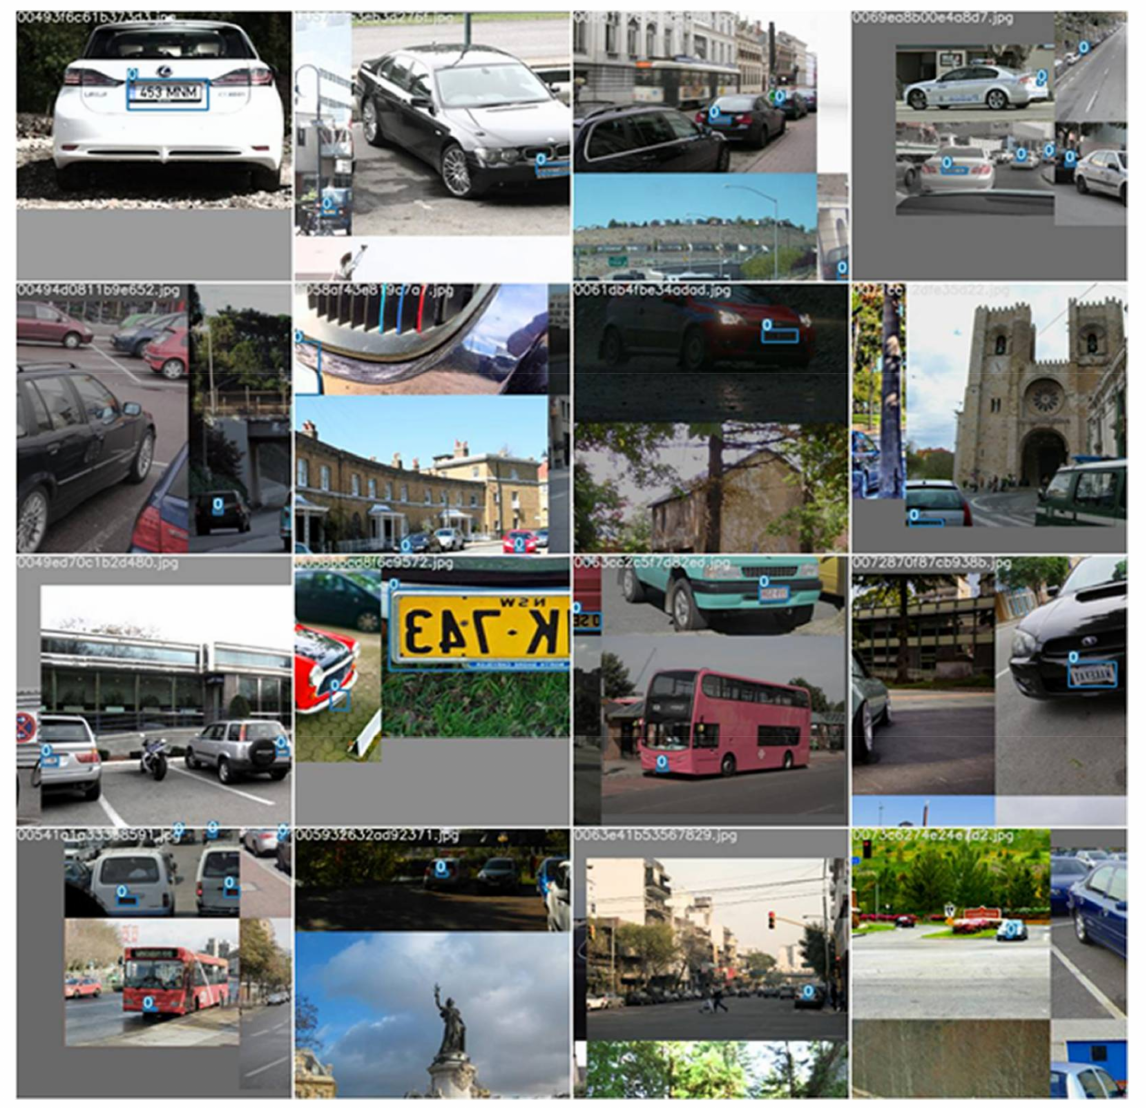
Figure 3. Random samples from the dataset (https://www.kaggle.com/datasets/dataturks/vehicle- number-plate-detection, accessed on 5 June 2022) (https://storage.googleapis.com/openimages/ web/index.html, accessed on 5 June